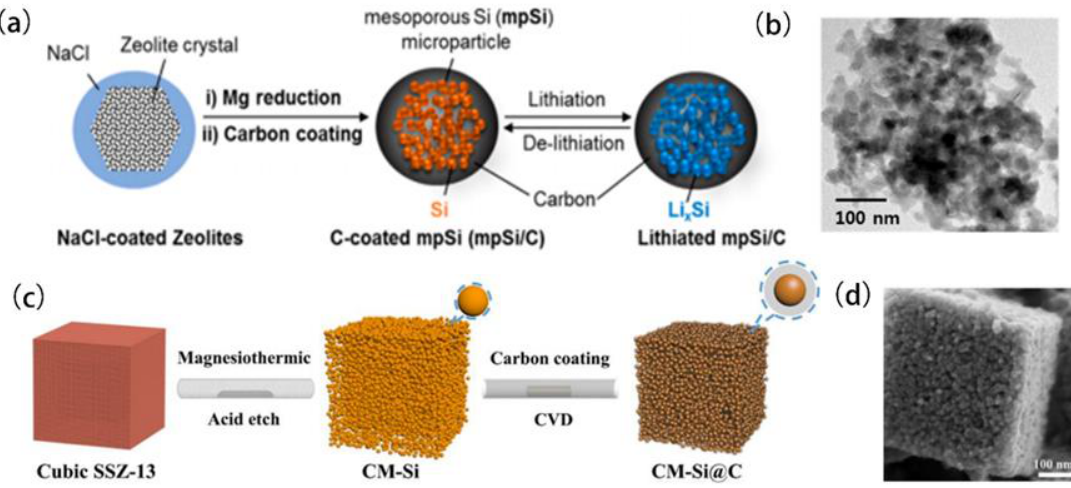
Figure 11. ( a ) Schematic illustration of the preparation process of pSi/C composite from zeolite template. ( b ) TEM images of pSi/C composite from zeolites template [91]. ( c ) Schematic illustration of the preparation process and ( d ) SEM images of CM-Si@C composite from SSZ-13 template [90]. Reprinted with permission from [91]. Copyright 2018 American Chemical Society. Reprinted with permission from [90]. Copyright 2018 Elsevier.